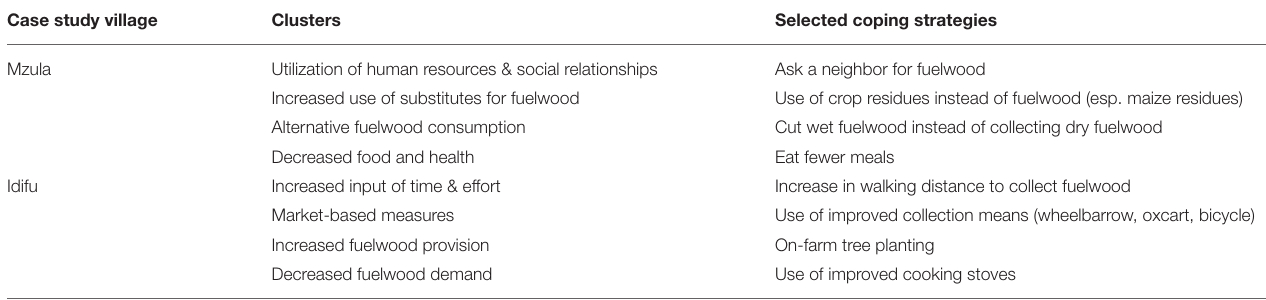
TABLE 2 | Eight coping strategies selected for the impact assessment and their clusters assigned to the respective case study villages. Case study village